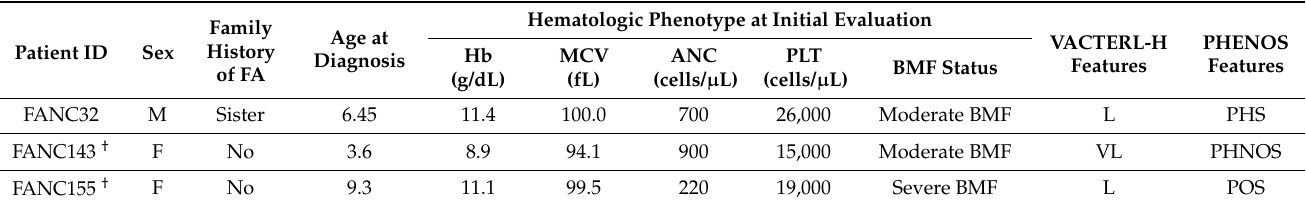
Table 4. Summary of the clinical phenotype of the patients described in this study.